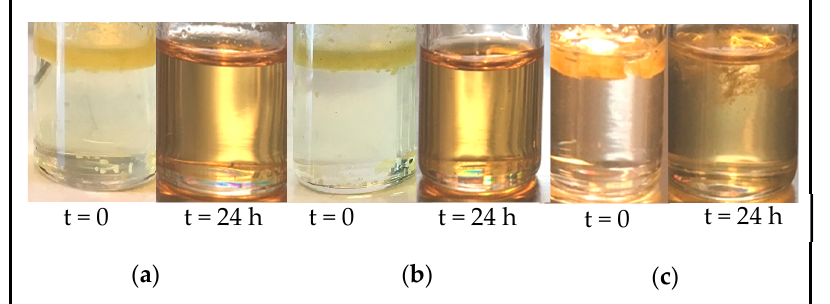
Figure 5. Solubility of FG1 ( a ), FG1A50 ( b ), and FG1A120 ( c ) in dichlorobenzene at 120 °C for 24 h.